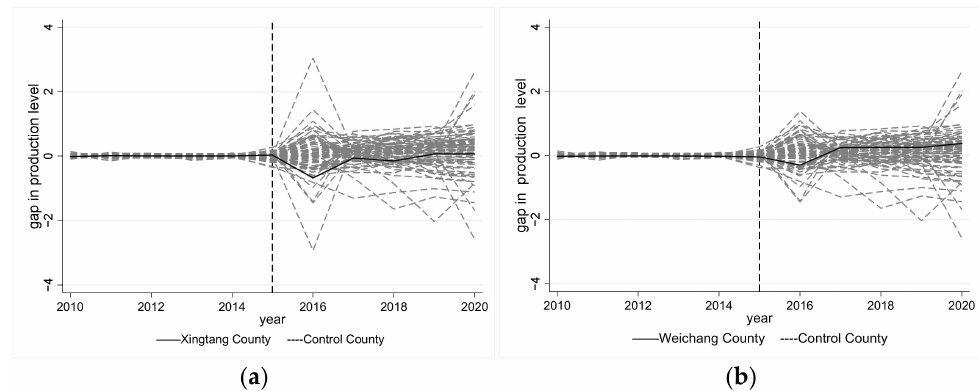
Figure 9. Sheep industry production level gaps in all sample points, ( a ) when Xingtang County is the treatment group, ( b ) when Weichang County is the treatment group.